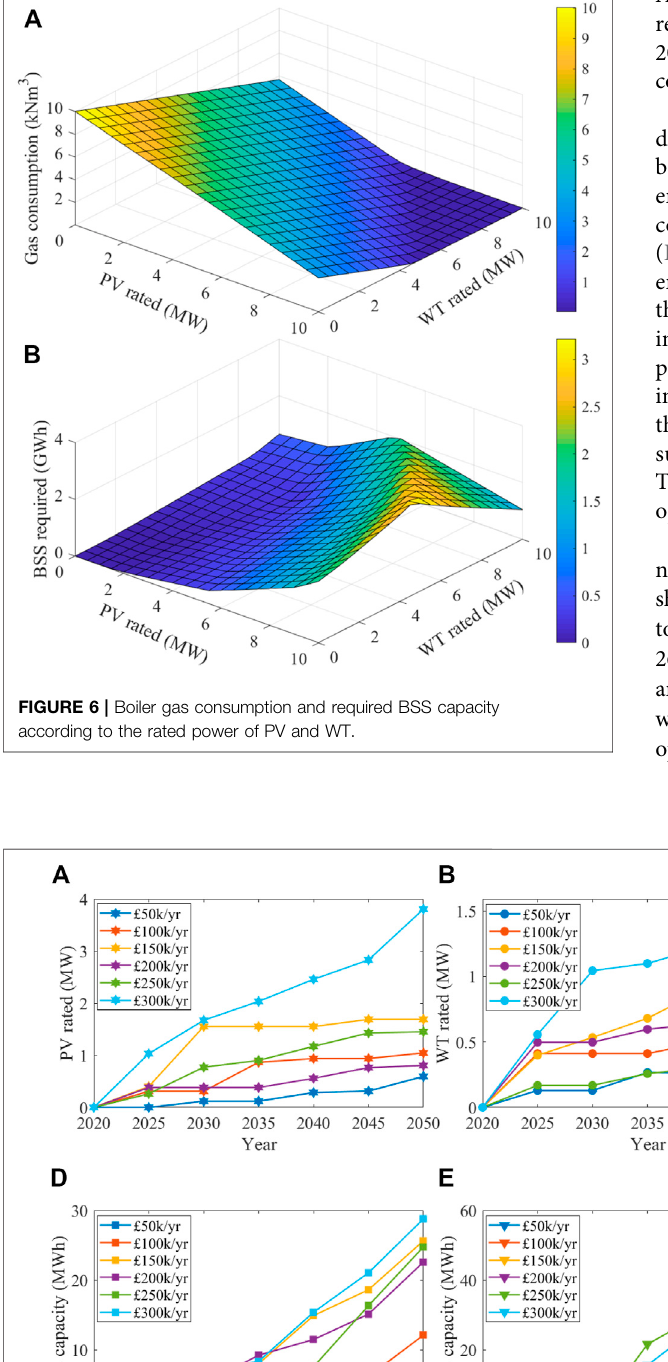
Frontiers in Energy Research |